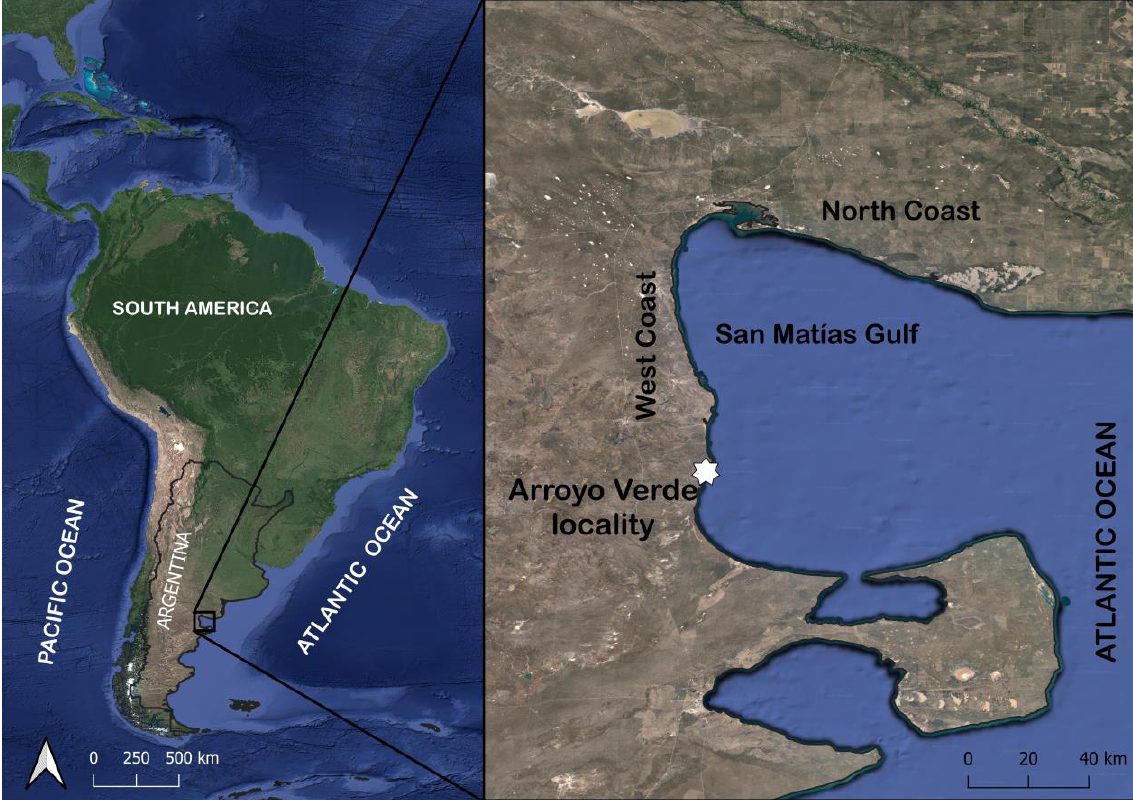
Figure 1. Location of the study